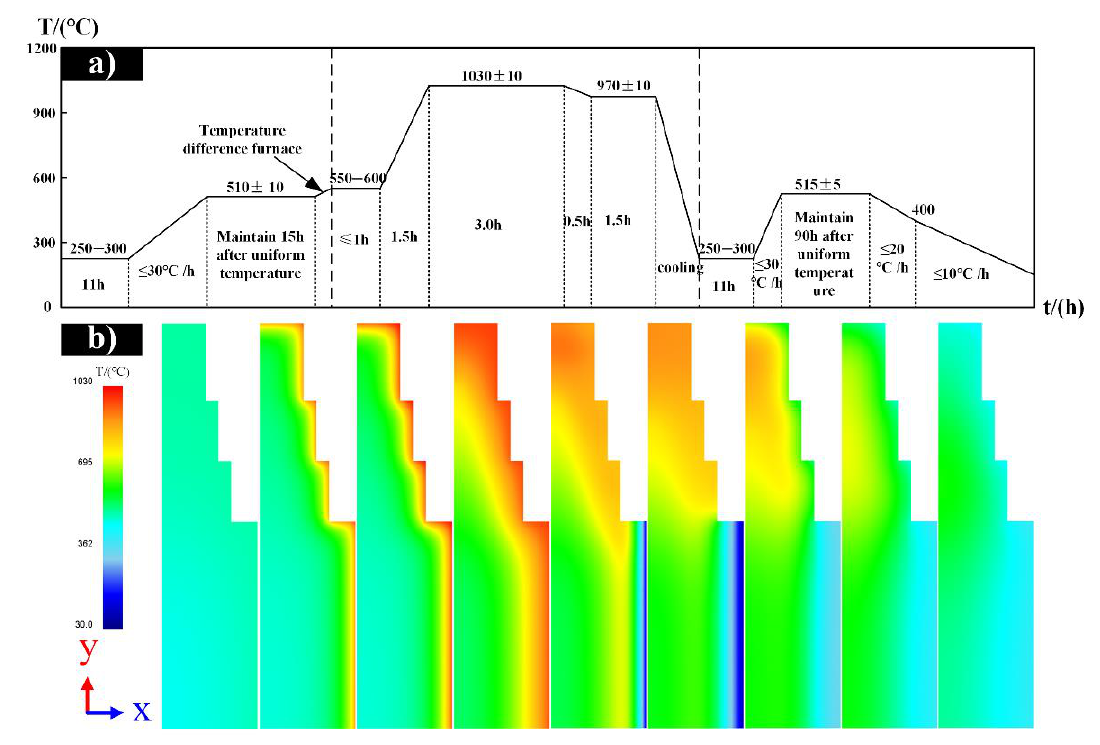
Figure 3. Heat treatment process and finite element simulation. ( a ) The whole process of heat treatment; ( b ) temperature cloud diagram of finite element simulation of forgings in different stages.